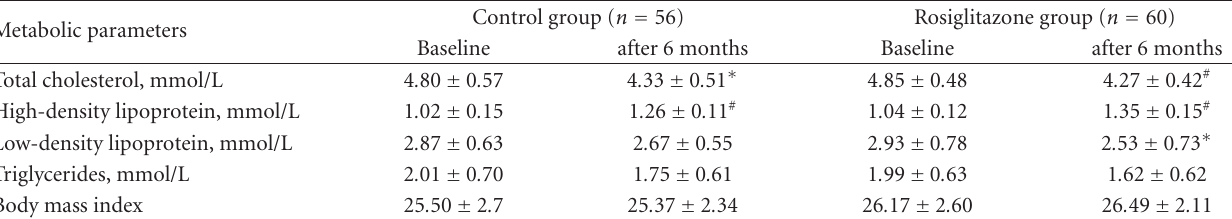
Table 2: Metabolic features of patients before and 6 months after rosiglitazone treatment. Values are mean ± SD. Metabolic